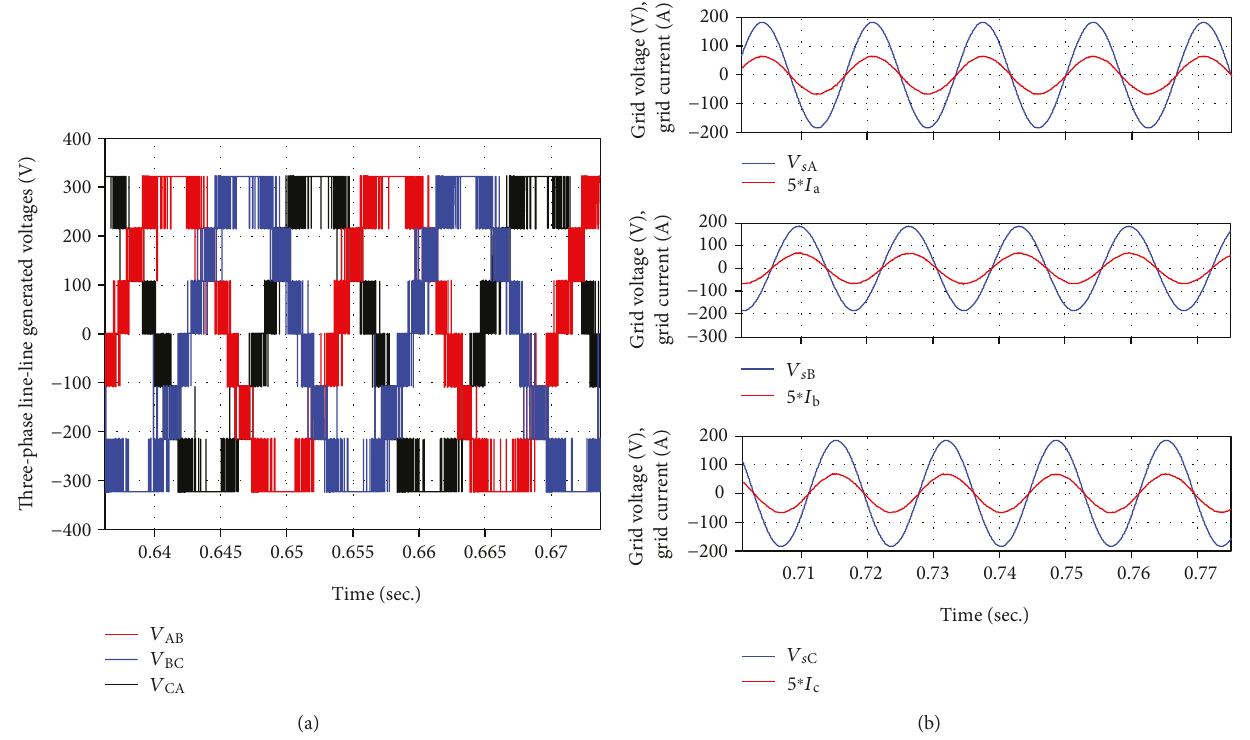
Figure 9: (a) Simulation results of three-phase voltage generated from con fi guration C. (b) Simulation results of grid voltages and grid currents of from con fi guration C. Table 3: Comparison of number of switches and